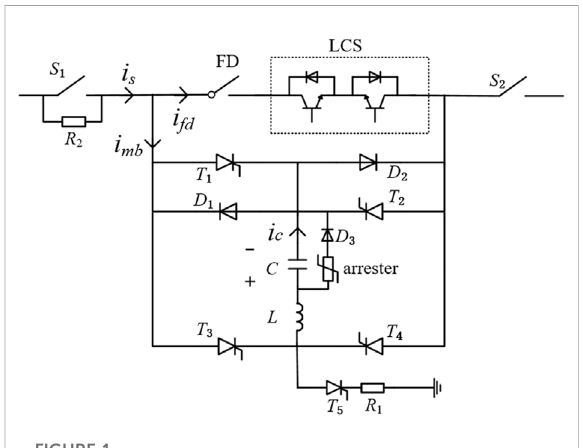
FIGURE 1 Topology of the capacitor-based DC circuit breaker.